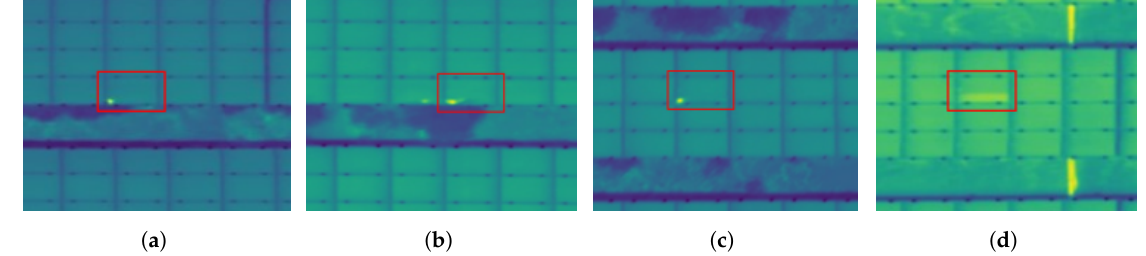
Figure 2. Three hotspots ( a – c ) and a bypass substring ( d ) in a 16-bit thermal image, here depicted using a two-channel image (using the ‘blue’ and ‘green’ channel).